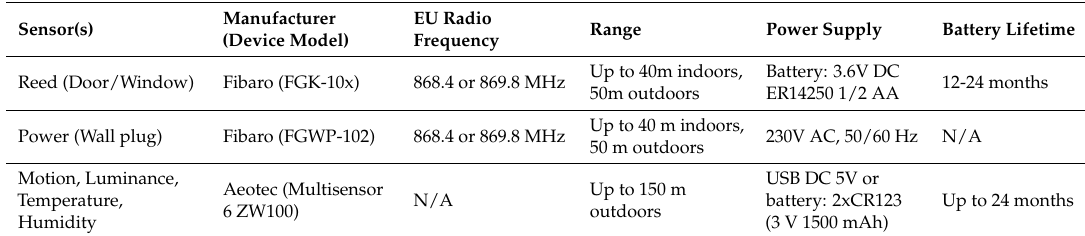
Table 2. Selected